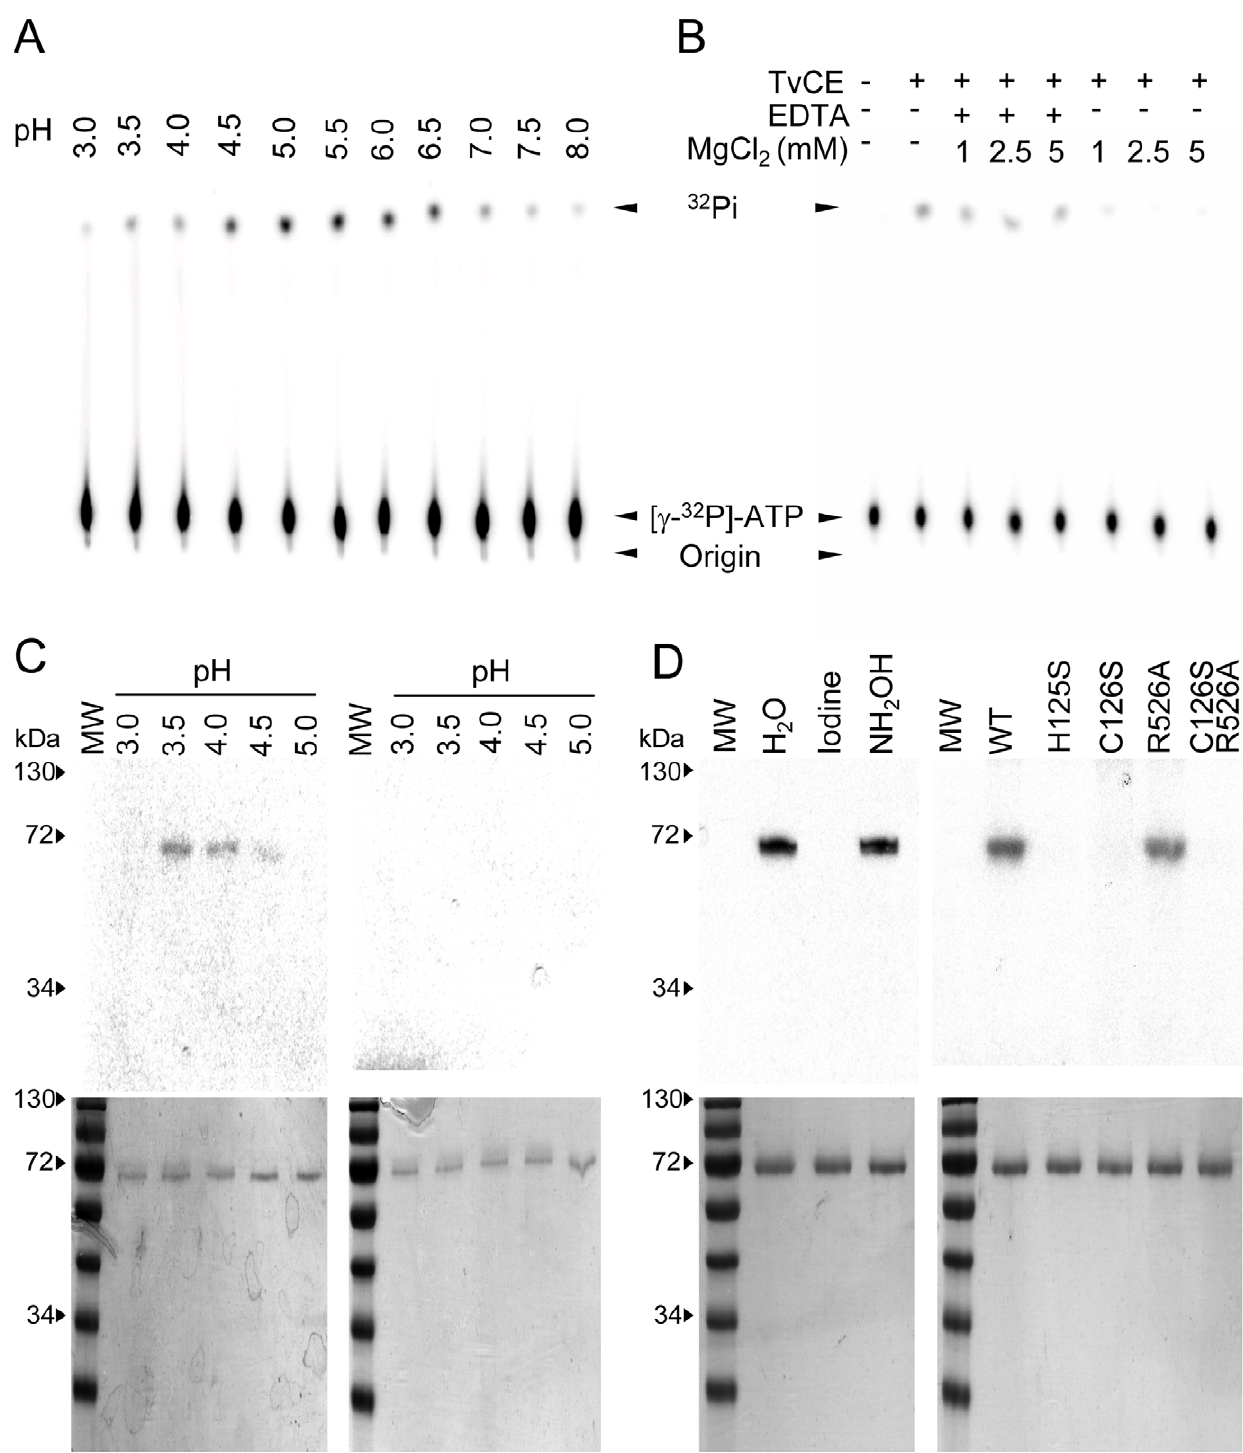
Figure 2. Triphosphatase activity of TvCE. A. Activity at various pHs. B. Effect of MgCl 2 and EDTA on activity. Products were resolved on TLC plates and detected by autoradiography. Arrows denote the origin of loading, substrate ([ c - 32 P]ATP) and product ( 32 Pi). C. Detection of the TvCE- cysteinyl-S-phosphate formation. Labeling with [ c - 32 P]ATP (left panel) and [ a - 32 P]ATP (right panel) compared from pH 3.0–5.0. 32 P-labeled TvCE detected by SDS-PAGE and autoradiography and TvCE protein loading controls flanked by pre-stained molecular weight markers (PageRuler prestained protein ladder, Fermentas) are shown in top and bottom panels, respectively. D. Effect of iodine and NH 2 OH on thiophosphate linkage formation (left panels) and TvCE-cysteinyl-S-phosphate formation of TvCE wild-type (WT) and mutant (H125S; C126S; R526A; C126S & R526A) proteins (right panels). 32 P-labeled TvCE detected by SDS-PAGE and autoradiography (top panels) and TvCE protein loading controls (bottom panels) are shown. The purified protein is observed as a single band of the predicted , 71 kDa molecular mass in both C and D.